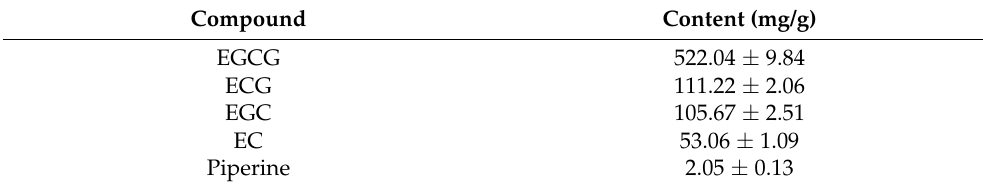
Figure 2. HPLC chromatogram of catechins ( A ) and piperine ( B ) in GTP. HPLC, high ‐ performance liquid chromatography; EGC, epigallocatechin; EC, epicatechin; EGCG, epigallocatechin ‐ 3 ‐ gallate; ECG, epicatechin ‐ 3 ‐ gallate; GTP, green tea complex containing Piper retrofractum fruit. Table 3. Contents of catechin and piperine in